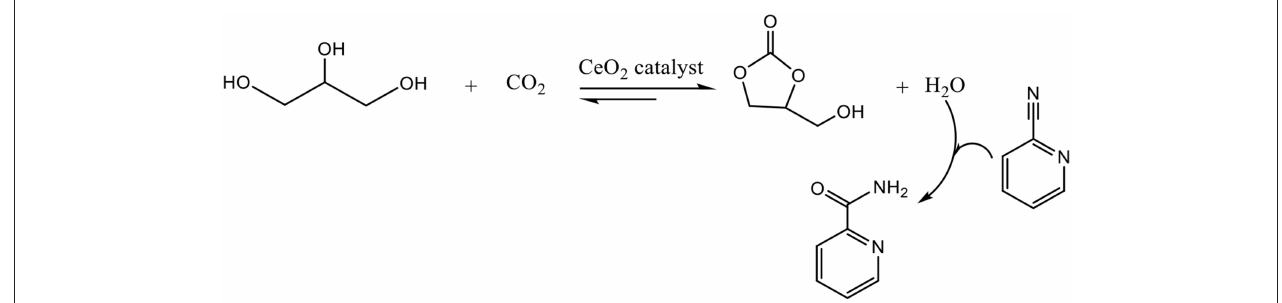
FIGURE 4 | Reaction of glycerol and CO 2 with CeO 2 in presence of 2-cyano-pyridine.